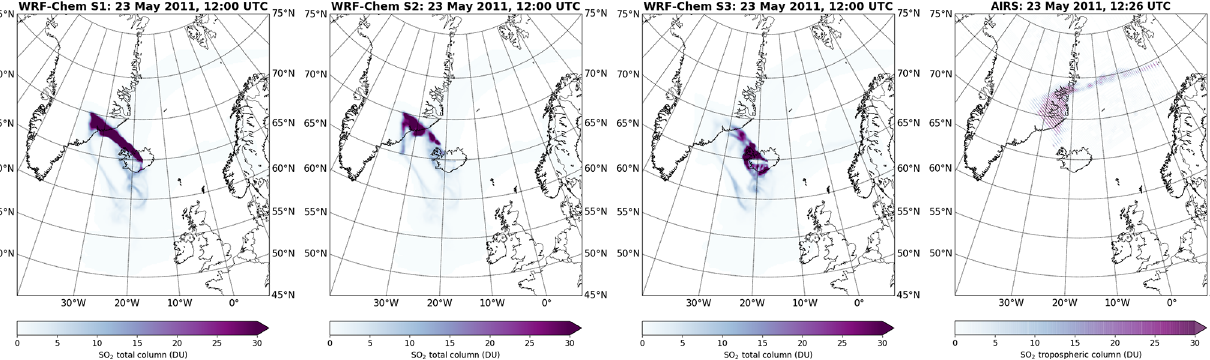
Figure 8. SO 2 total columns (DU) from WRF-Chem simulations (S1, S2, and S3) compared to the AIRS observations on 23 May 12:00.